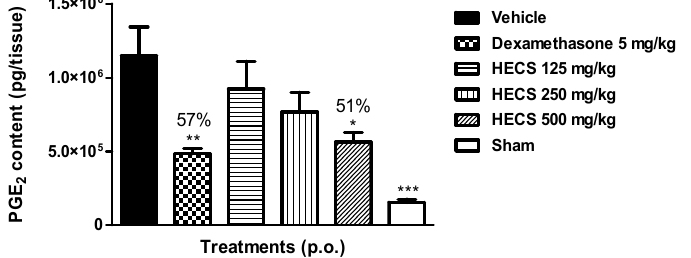
Figure 4. Effect of the hydroalcoholic extract of C. sicyoides— HECS (125, 250 and 500 mg/kg, p.o.) on the production of PGE 2 in ear edema induced by arachidonic acid (AA). The results are expressed as the mean ± S.E.M., and statistical significance was determined by ANOVA followed by Dunnett’s test; * p < 0.05, ** p < 0.01, *** p < 0.001 compared to the control group (vehicle). The numbers in percentage in the figure corresponds to the production of the PGE 2 in relation to the control group treated with vehicle ( n = 8).